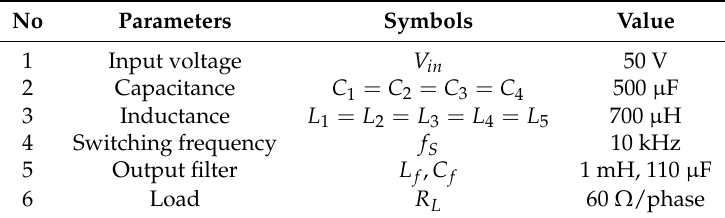
Table 2. Simulation